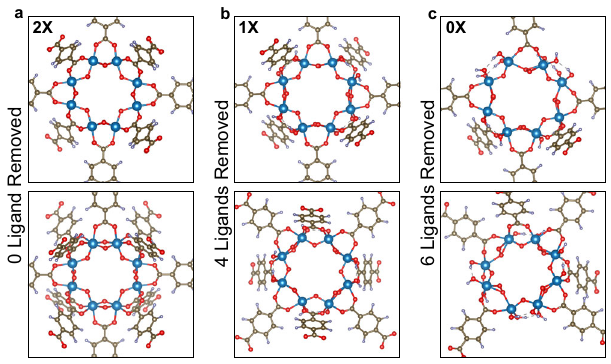
Fig. 7 DFT simulations. Schematic representations (top view and tilted) of the MIL frameworks with 0 ( a ), 4 ( b ) and 6 ( c ) ligands out of 12 ligands removed. A slight distortion of the pores can be seen in case c.